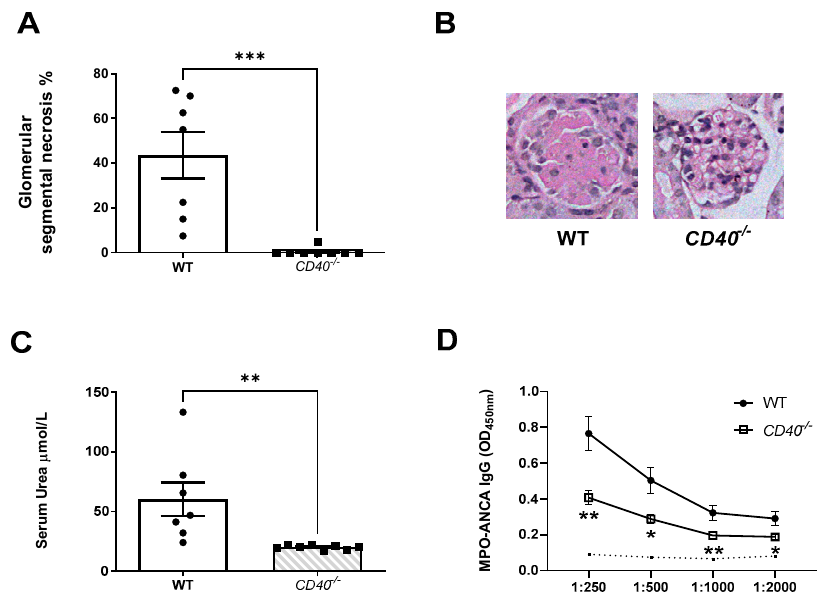
Figure 6. CD40 upregulation on TLR9 simulated MPO pulsed dendritic cells is critical for the development of kidney injury following the transfer of TLR9 stimulated MPO pulsed dendritic cells and the triggering of kidney injury. ( A , B ): Abrogated kidney injury in mice receiving TLR9 stimulated MPO pulsed CD40 − / − DCs. Periodic-acid Schiff-stained micrographs of glomeruli were taken at original magnification × 400. ( C ): Serum urea measurement in µ mol/L. Reduced in mice receiving TLR9 stimulated MPO pulsed CD40 − / − DCs. ( D ): Decreased serum MPO-ANCA IgG in mice receiving TLR9 stimulated MPO pulsed CD40 − / − DCs compared to WT DCs. Dotted line represents the OD 450 of sera from control, OVA immunized mice receiving anti-GBM globulin. Bars show the mean +/ − SEM. * = p < 0.05, ** = p < 0.01, *** = p < 0.001. DC = Dendritic cell. Mouse numbers for experiment: WT: n = 7, CD40 − / − : n =